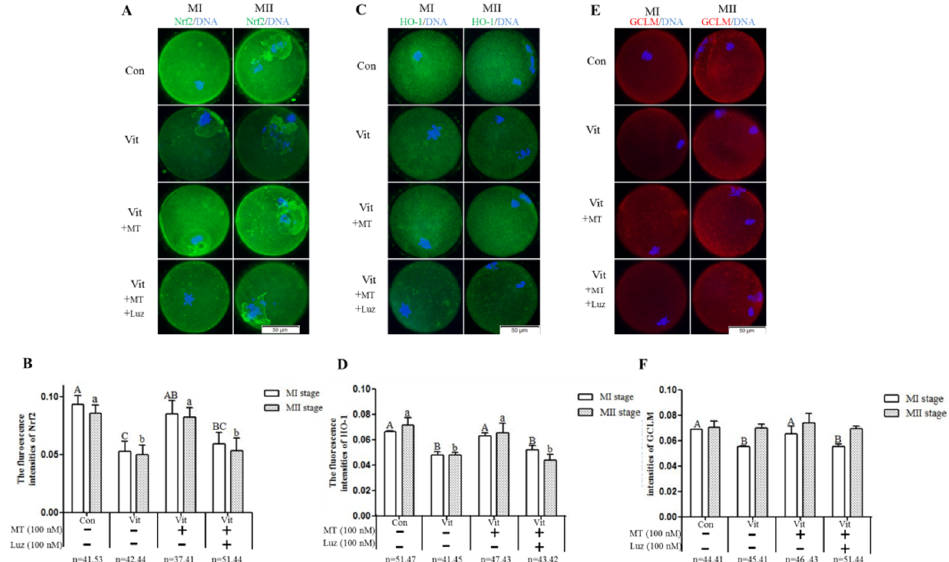
Figure 10. Effects of melatonin (MT) and luzindole (Luz) on the expression of Nrf2 pathway-related antioxidant proteins during in vitro maturation of vitrified-warmed mouse GV oocytes. Immunofluorescence of Nrf2 ( A , B ), HO-1 ( C , D ) and GCLM ( E , F ). Data are presented as mean ± SEM of three independent experiments. Values with different superscripts A (a), B (b), and C (c) are different ( p < 0.05) between groups at the same stages. Scale bar = 50 µm. The four experimental groups: control (Con), vitrification (Vit), vitrification + melatonin (Vit + MT), and vitrification + melatonin + luzindole (Vit + MT + Lru). Notes: MI: metaphase I; MII: metaphase II.